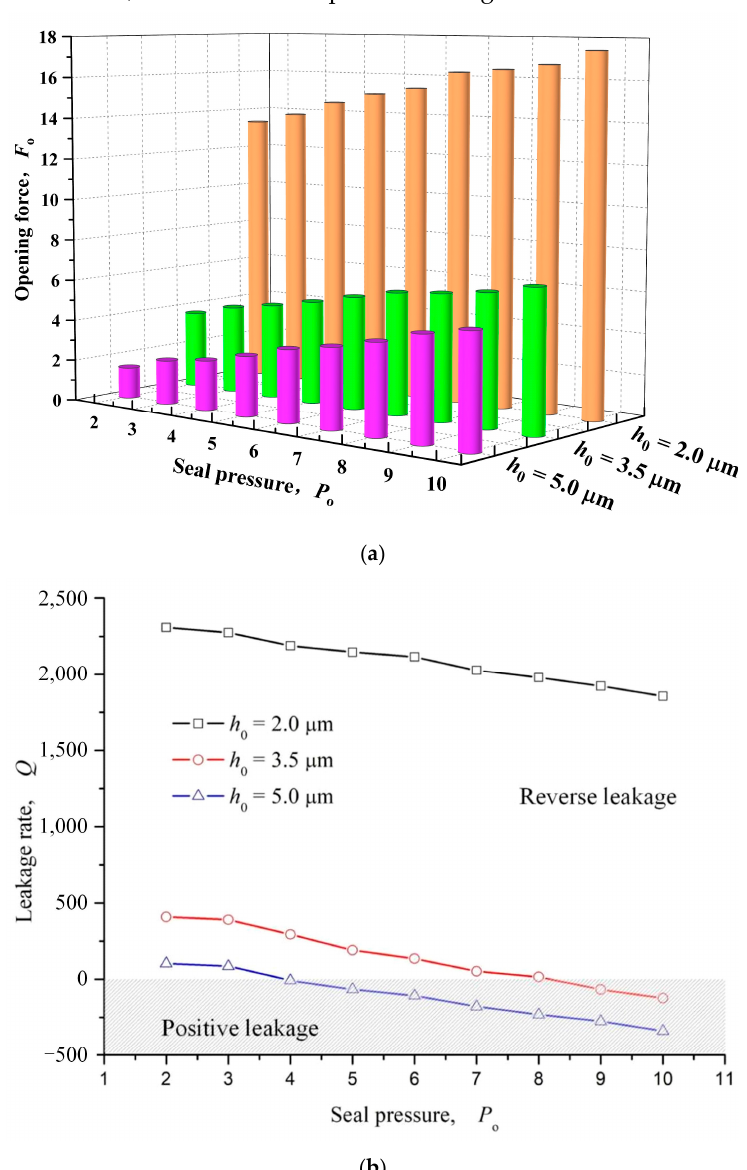
Figure 9. In fl uence of seal pressure on opening force and leakage rate ( ω = 12,000 rpm, h 0 = 2 μ m, h d = 5 μ m, γ = 3, α = 40°, N = 80). ( a ) Opening force; ( b ) Leakage